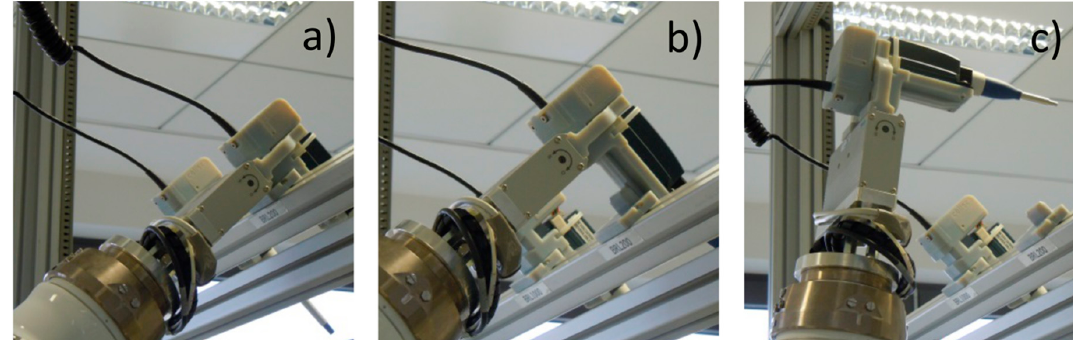
Figure 7. Pipette pick–up: ( a ) Slightly grasp the pipette (soft grip) to prevent tilting the pipette, ( b ) strongly grasp the pipette (hard grip) after lift–up from the place holder, and ( c ) complete pipette lift–up.